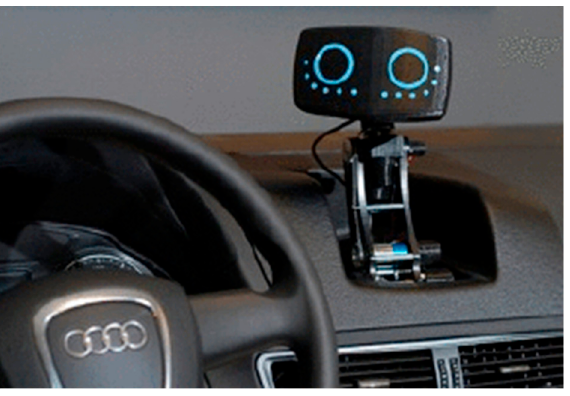
Figure 1. ( a ) NIO’s NOMI. ( b ) BYD’s Qin.